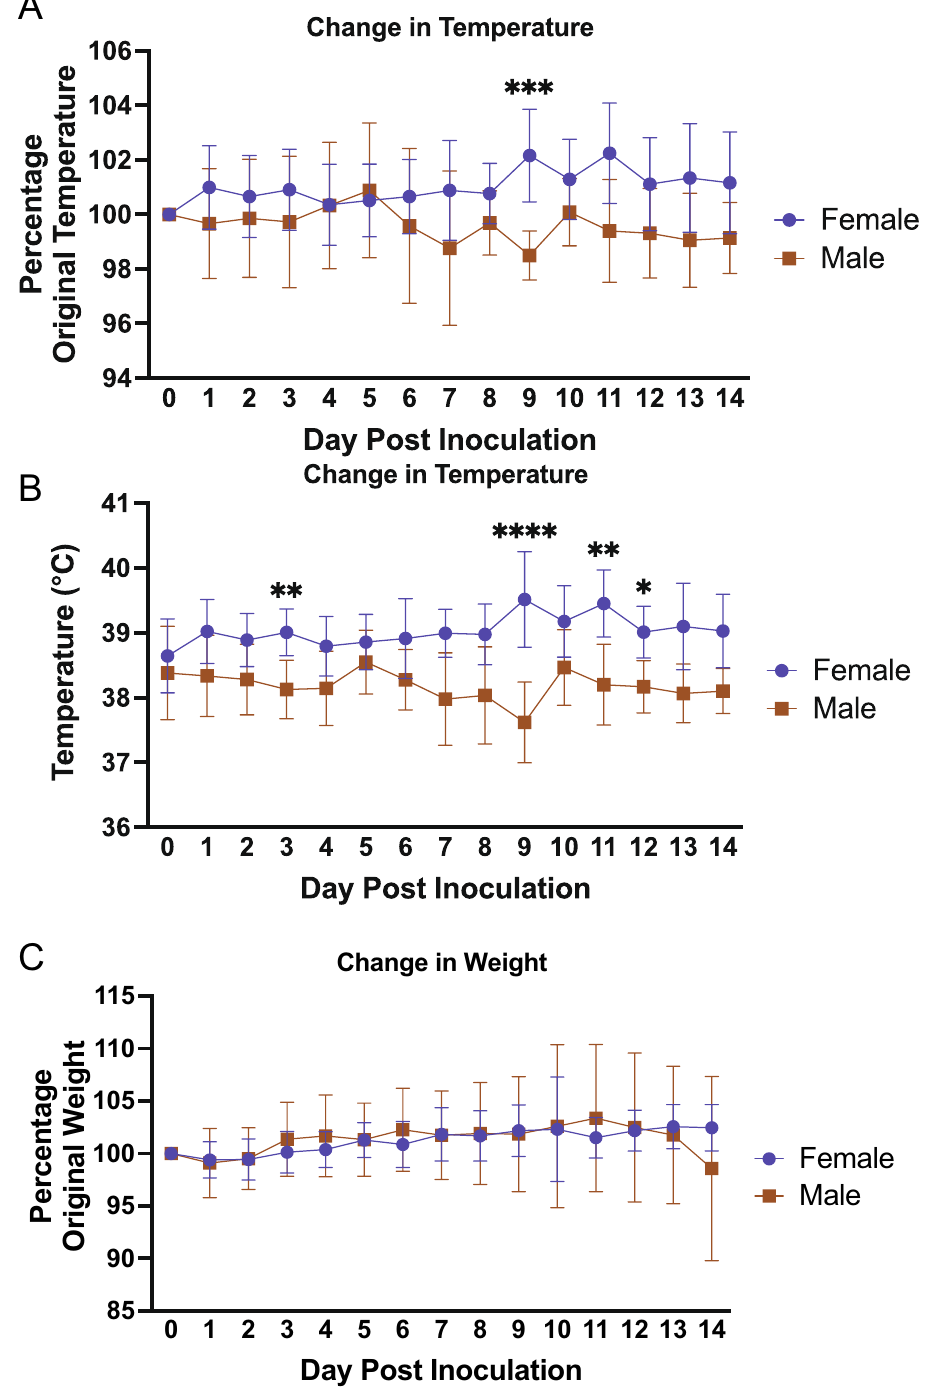
Figure 1. Intranasal SARS-CoV-2 infection in sexually intact ferrets leads to significantly lower temperature in males compared to females. ( A ) Sexually intact 1-year-old female and 1-year-old male ferrets were intranasally inoculated with the Severe Acute Respiratory Syndrome coronavirus 2 (SARS-CoV-2) (10 6 TCID 50 ) and weight was recorded for 14 days post inoculation and represented as percentage of original temperature and ( B ) raw temperature. ( C ) Weight was also measured for 14 days after inoculation and represented percentage of original weight. Results show the mean of at least 6 ferrets per group. Results show the mean of at least 6 ferrets per group. *A p-value less than 0.05 determined by ANOVA comparing females to males. Error bars indicate ± standard deviation